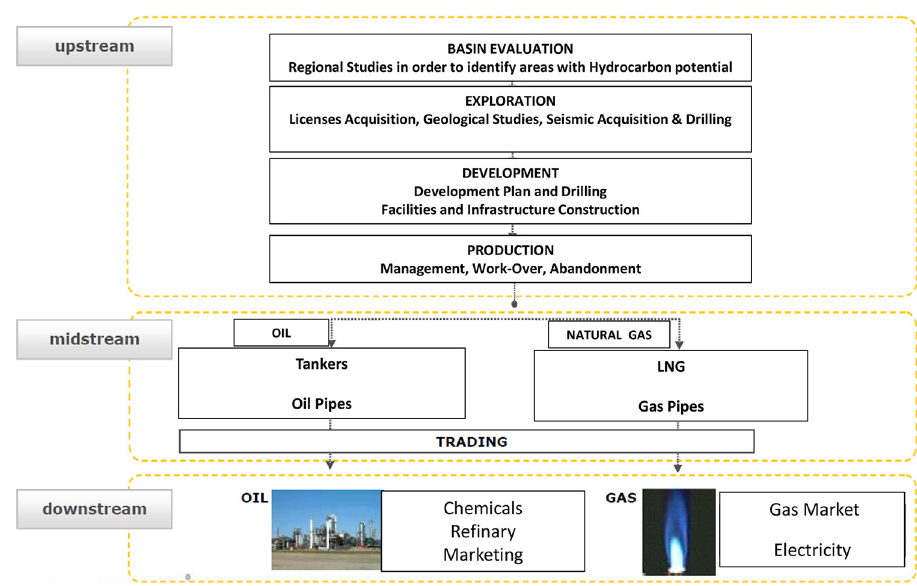
Fig. 1. – The oil & gas cycle: Eni covering the entire